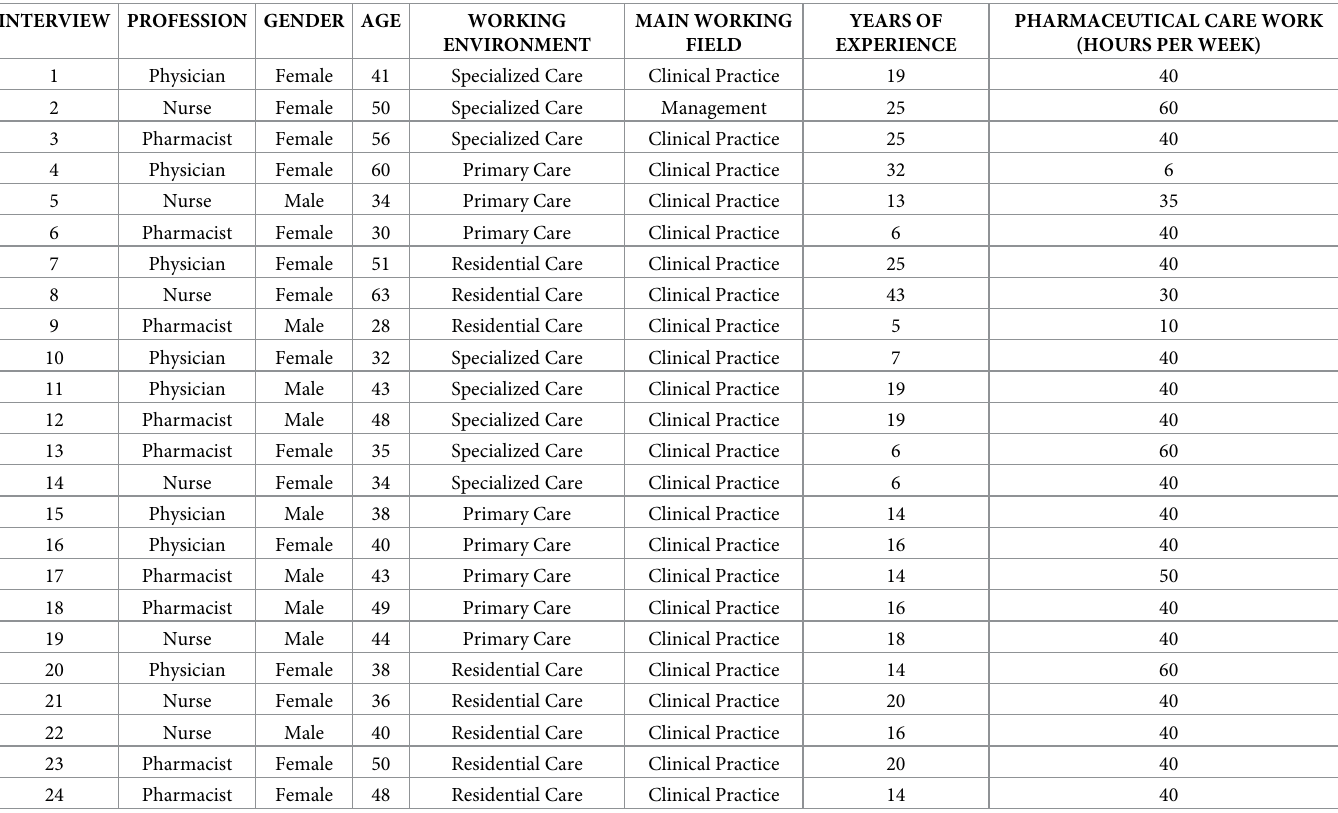
Table 1. Participants’ sociodemographic